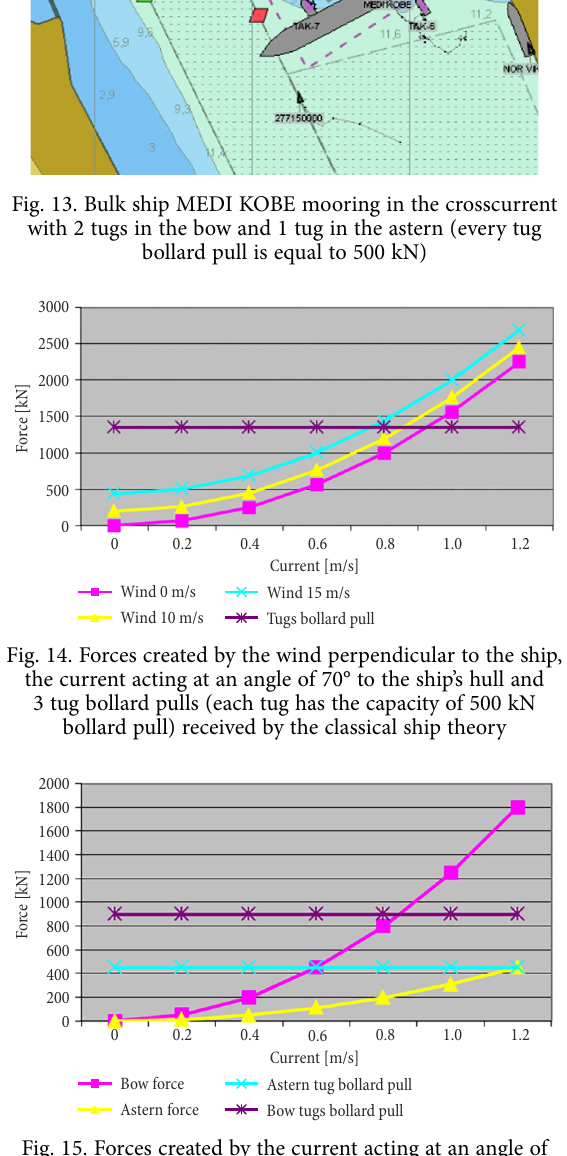
Fig. 15. Forces created by the current acting at an angle of 70° to the ship’s hull and 2 tugs working on the ship’s bow and 1 tug working on the ship’s astern (each tug has the capacity of 500 kN bollard pull) required tugs bollard pull received by the method presented in the